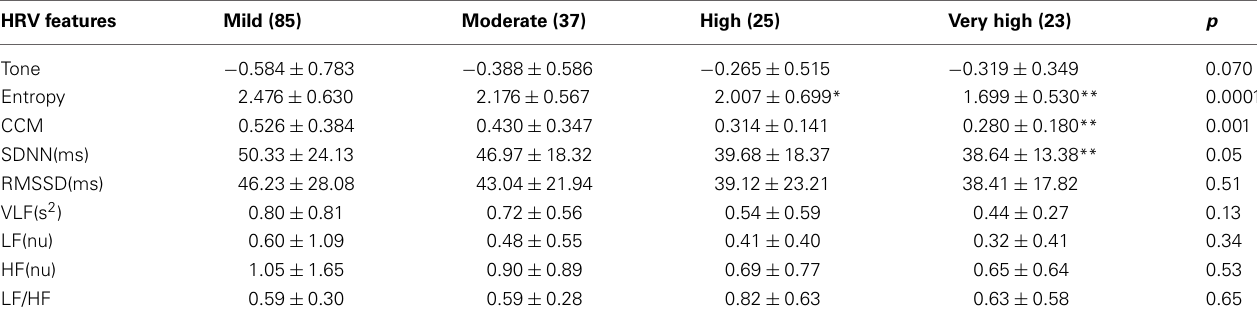
Table 2 | Heart rate variability results for CVD risk